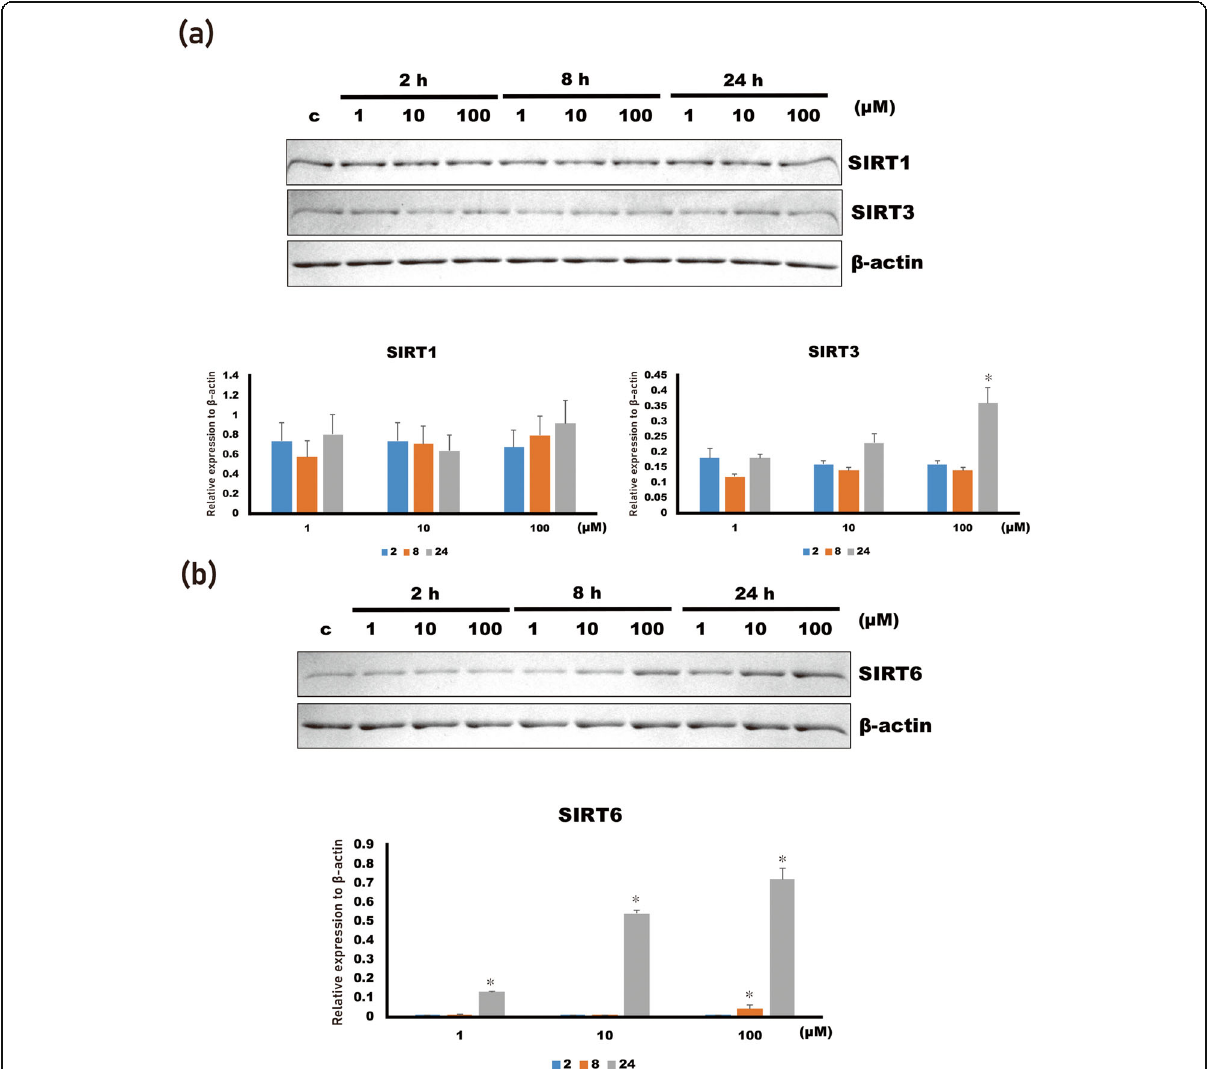
Fig. 1 Western blot for SIRT1, 3, and 6. a The expression level of SIRT1 was not significantly changed by 4HR administration (1 – 100 μ M). However, the expression level of SIRT3 was significantly increased in the 100 μ M 4HR group at 24 h after administration (* p < 0.05). b The expression level of SIRT6 was significantly increased in the 1 – 100 μ M 4HR group at 24 h after administration and in the 100 μ M 4HR group at 8 h after administration (* p <